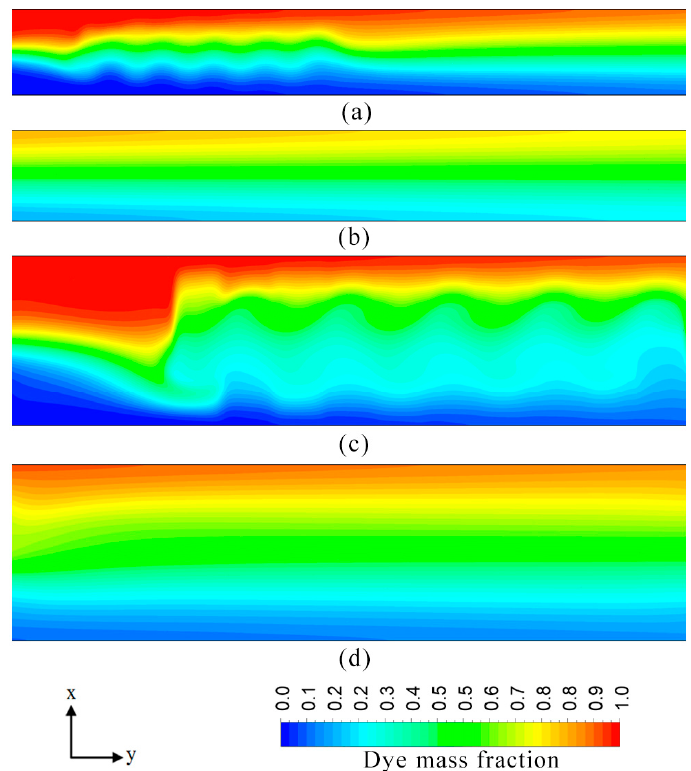
Figure 10. Dye mass fraction distributions on x - y plane at z / H c = 0.5 for E = 400 V/cm: ( a ) W c / H c = 3.33; near inlet ( x / L c = 0.05–0.42); ( b ) W c / H c = 3.33; near exit ( x / L c = 0.56–1.0); ( c ) W c / H c = 8.33; near inlet ( x / L c = 0.15–0.5); and ( d ) W c / H c = 8.33; near exit ( x / L c = 0.6–1.0).